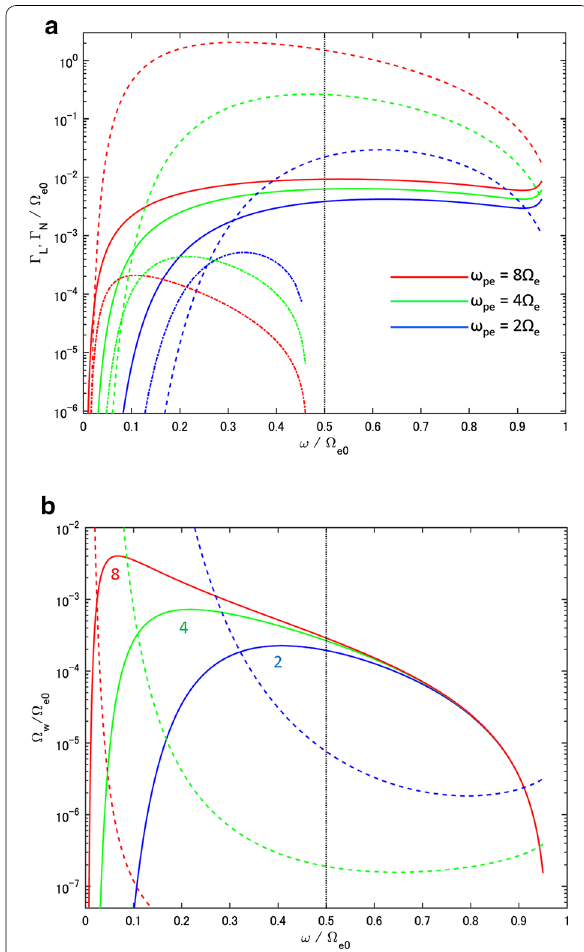
Fig. 6 Nonlinear wave growth theory. a Linear growth rates (dash– dot lines) and nonlinear growth rates at the threshold amplitudes (dashed lines) and the nonlinear growth rates at the optimum amplitudes (solid lines). A subtracted Maxwellian for the energetic 0.25 c , and 1.0 , U t 0.3 , ρ electrons is assumed with β = = � = U t 3.0 c . b Optimum and threshold amplitudes in solid and ⊥ = dashed lines for different values of the plasma frequency. ω pe 2, = 4, 8 (cid:31) e in blue, green, and red, respectively. The plasma frequency 0.1789 corresponding to of hot electrons is kept constant as ω ph = n n c 4 � 2 10 − 3 for ω pe h / = = ×